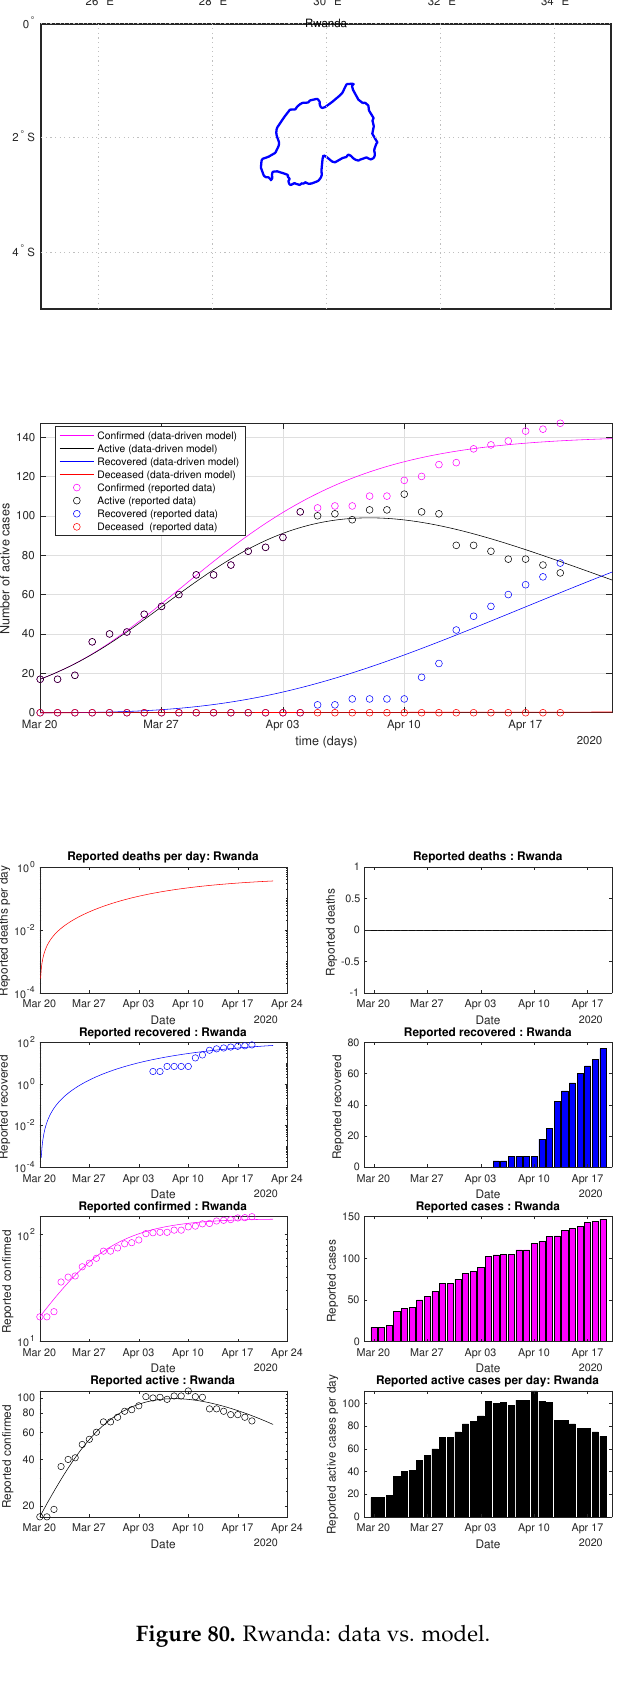
Figure 80. Rwanda: data vs.